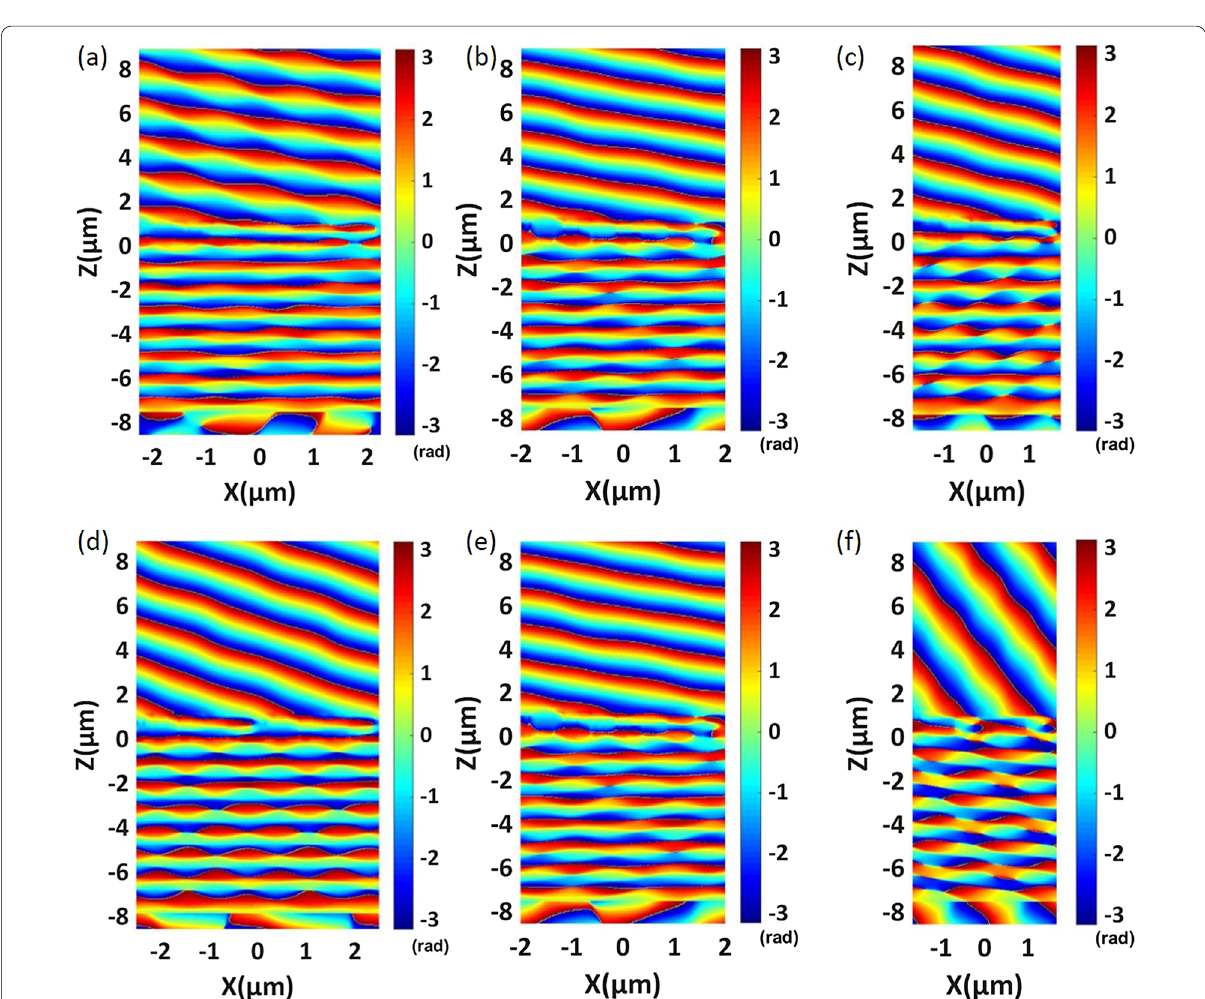
Fig. 7 Phase distribution of a phase-gradient metasurface consisting of different element numbers. a Nine-element metasurface. b Eight-element metasurface. c Seven-element metasurface. d Five-element metasurface. e Four-element metasurface. f Three-element metasurface. d – f depict two periods to better show the anomalous transmission effect. The detailed parameters are shown in Table